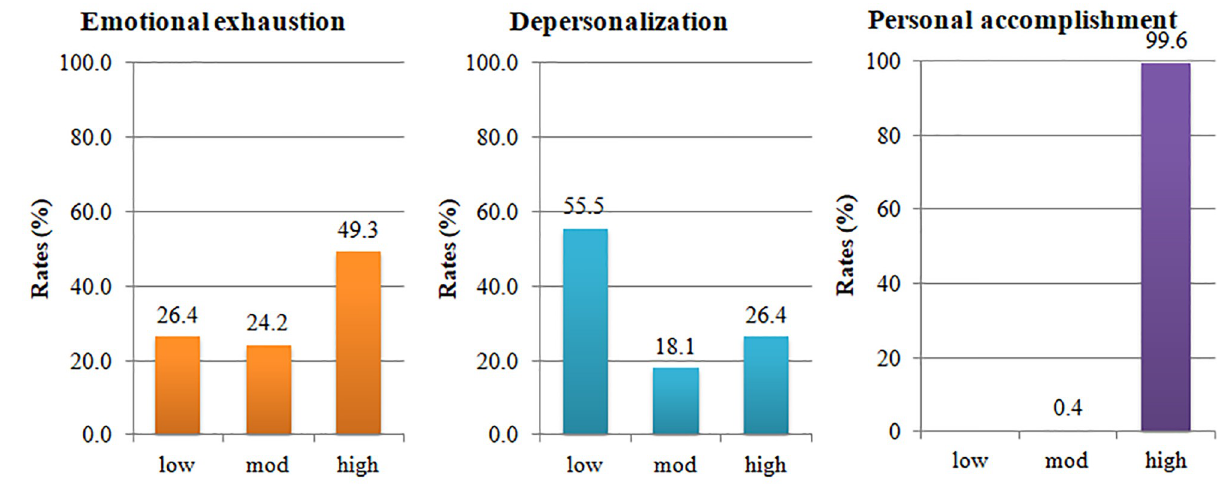
Fig 1. Burnout rates according to the Maslach Burnout Inventory (MBI) subscales.